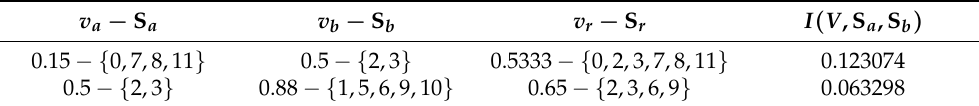
Table 4. Candidate structures for the fourth iteration.